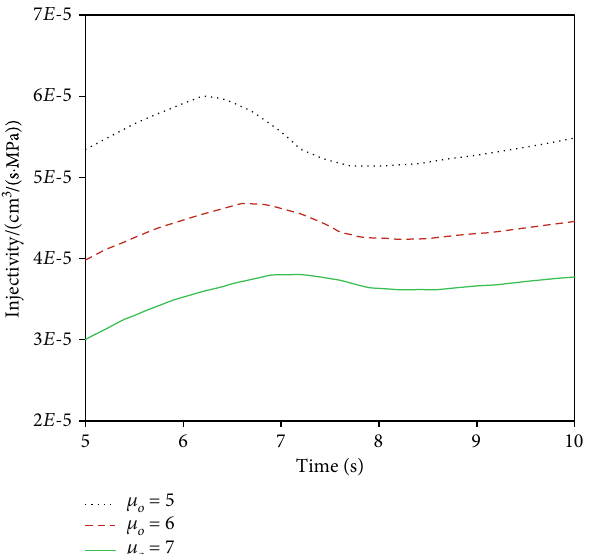
Figure 7: Injectivity change with time for di ff erent CO